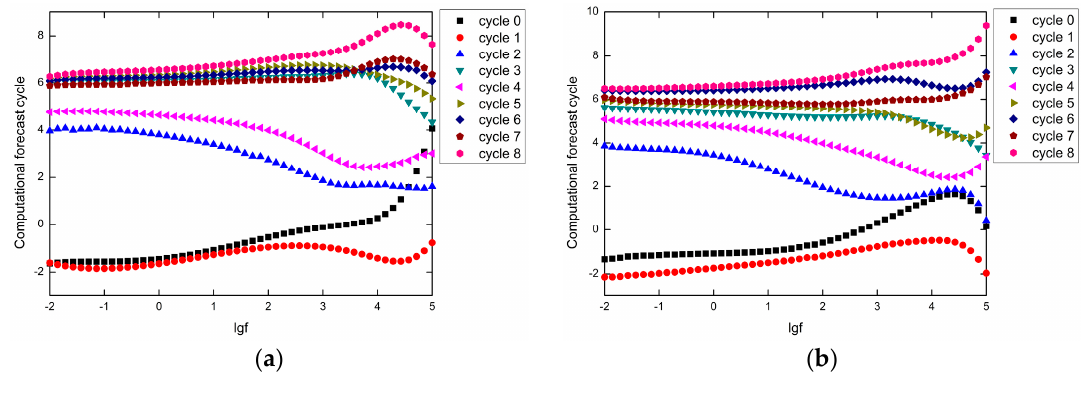
Figure 8. Results of T i : ( a ) Plate 1#; ( b ) Plate 2#.